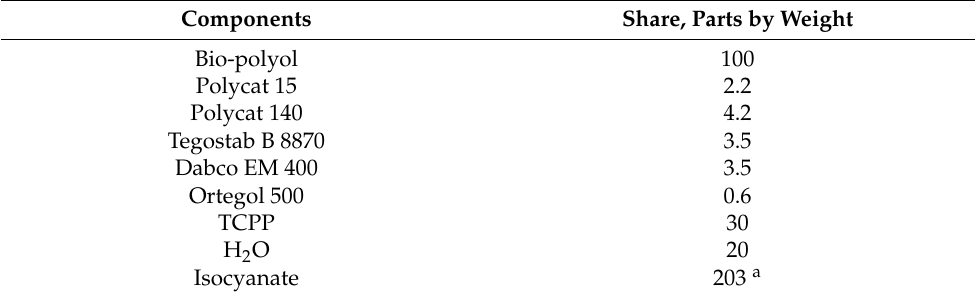
Table 2. Formulation of PUR